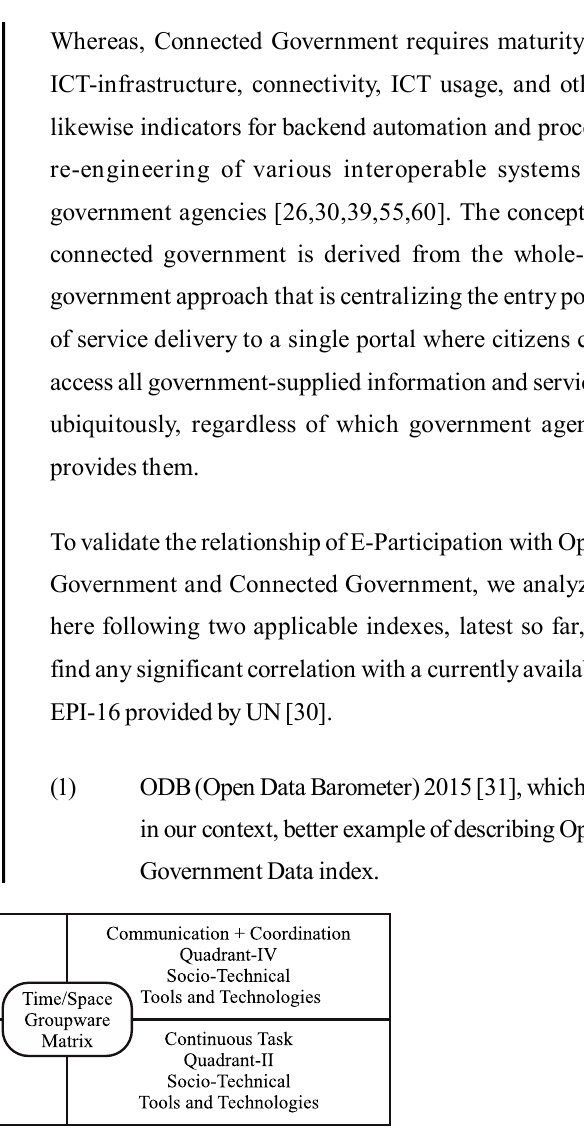
FIG. 3. TIME/SPACE GROUPWARE MATRIX OF CSCW